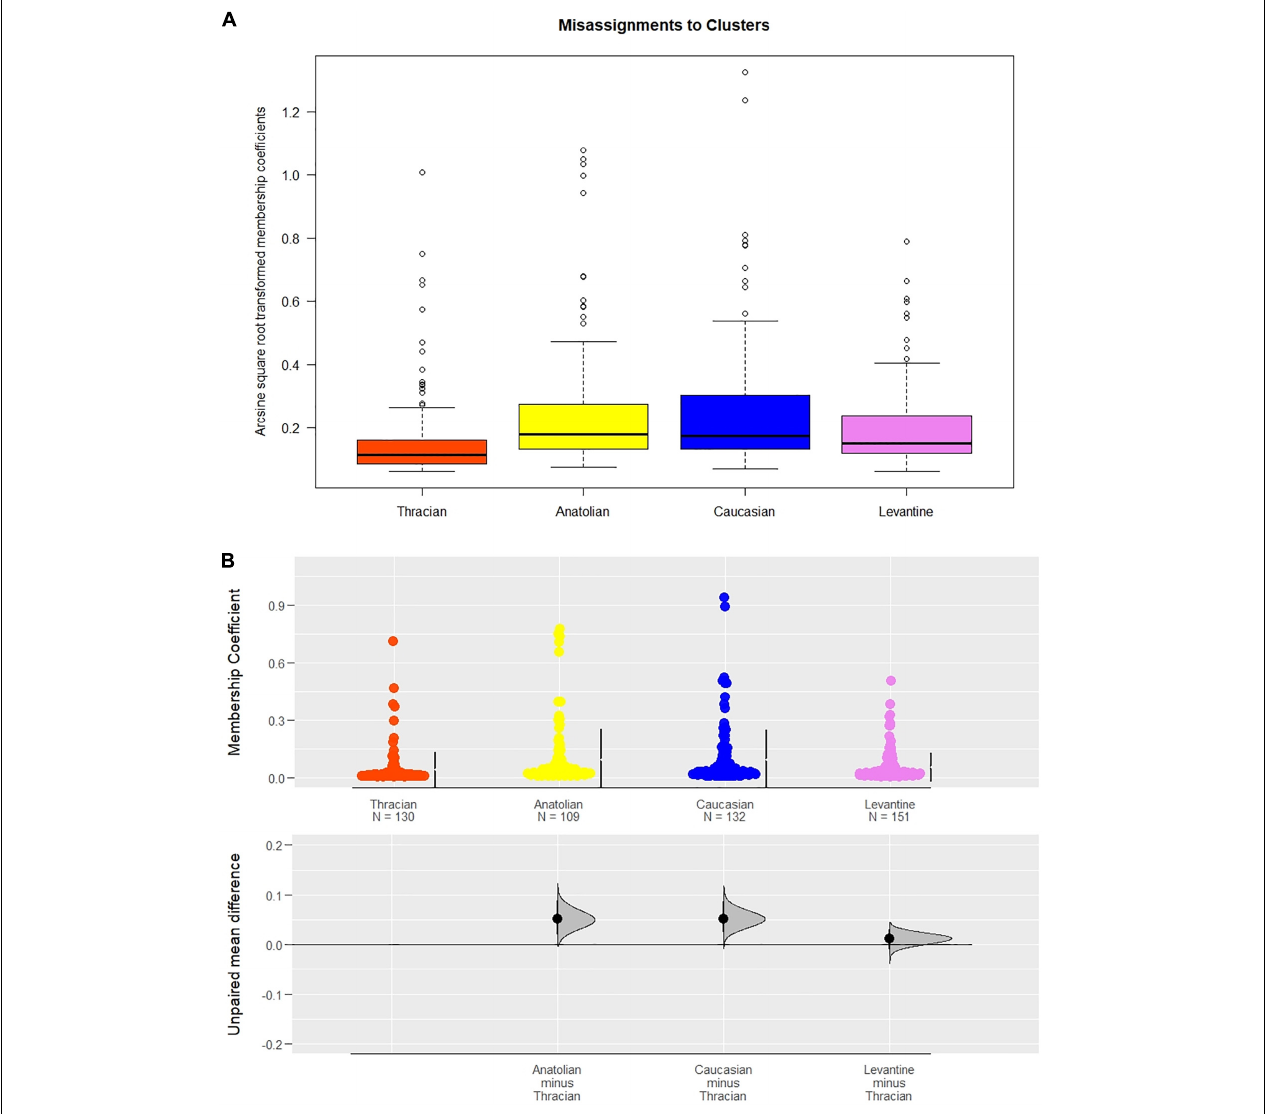
FIGURE 6 | Mis-assignment of individuals to caucasica and anatoliaca clusters were significantly more frequent than the others ( p < 0.001 for both subspecies against C-lineage Thracian bees and p < 0.05 against syriaca group). (A) Boxplot display of arcsine square-root transformed membership coefficients mis-assigned to each cluster. (B) Scatter plot with estimations of mean differences against Thracian mis-assignments based on raw individual membership coefficients (orange: C-lineage Thracian cluster, yellow: anatoliaca , blue: caucasica , violet: syriaca ). Bars right to the data points refer to the 25 and 75% quartiles and the gap between them is the median